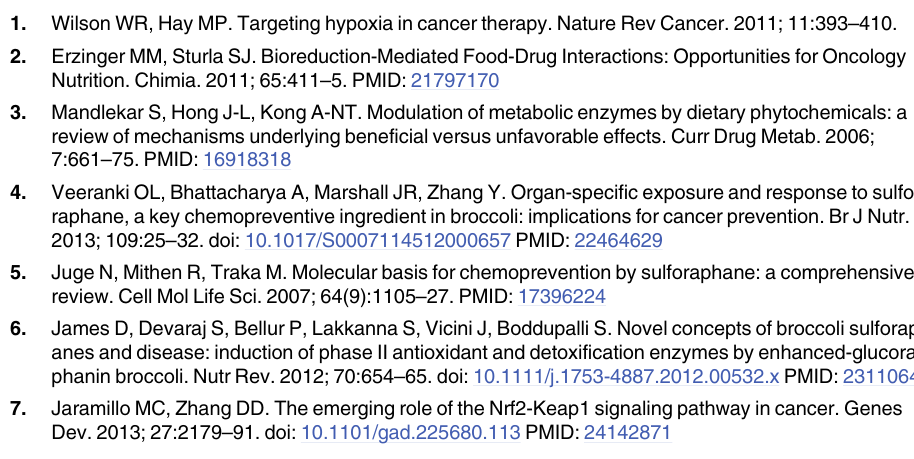
S2 Table. Relative value for quantification of western blots showing levels of AKR1C3 pro- tein in HT29 cells treated with either non-targeting siRNA or siAKR1C3 with or without simultaneous SF treatment (control = 0.1% DMSO). One representative western blot is shown in Fig 3D. Densitometry analysis was done using ImageJ software. Relative expression and 95% confidence interval was calculated for three independent replicates, normalized to a value of 1.0 for non-targeting DMSO sample. S3 Table. Relative value for quantification of western blots showing levels of AKR1C3 pro- tein in seven cell colon cell lines treated with or without 2.5 μ M SF for 48 h (control = 0.1% DMSO). One representative western blot is shown in Fig 4B. Densitometry analysis was done using ImageJ software. Relative expression and 95% confidence interval was calculated for three independent replicates, normalized to a value of 1.0 for HT29 DMSO